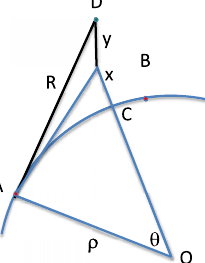
FIG. 1. A source particle at the point A (in red color) moves along a circular orbit and radiates electromagnetic fields that reach a test particle at the point D (green). The black colored lines are out of the orbiting plane.